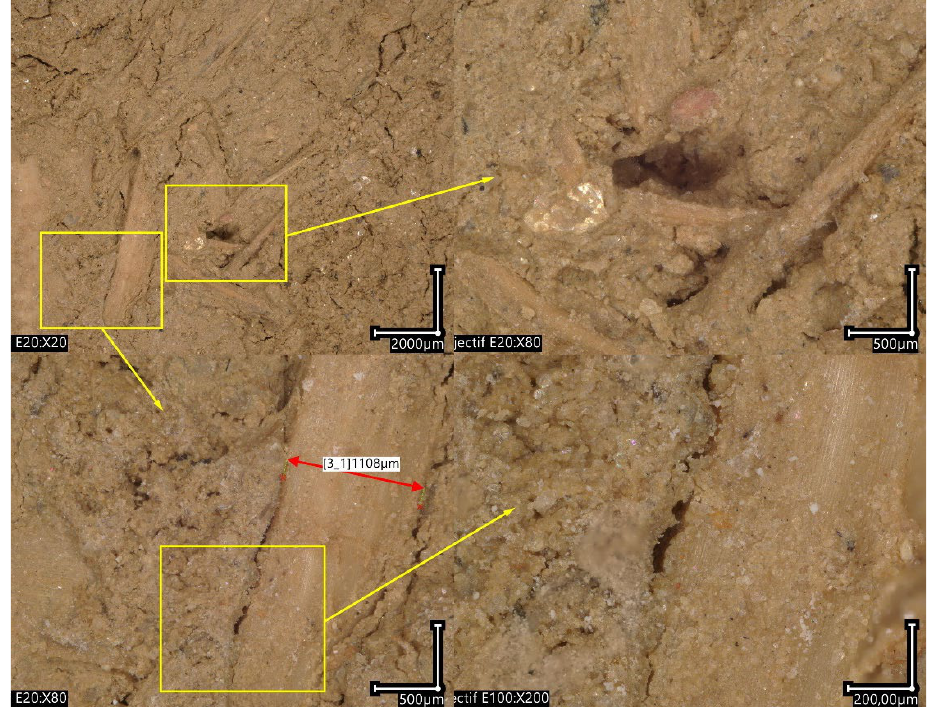
Figure 5. Microscopic observation of the composite raw earth/straw.